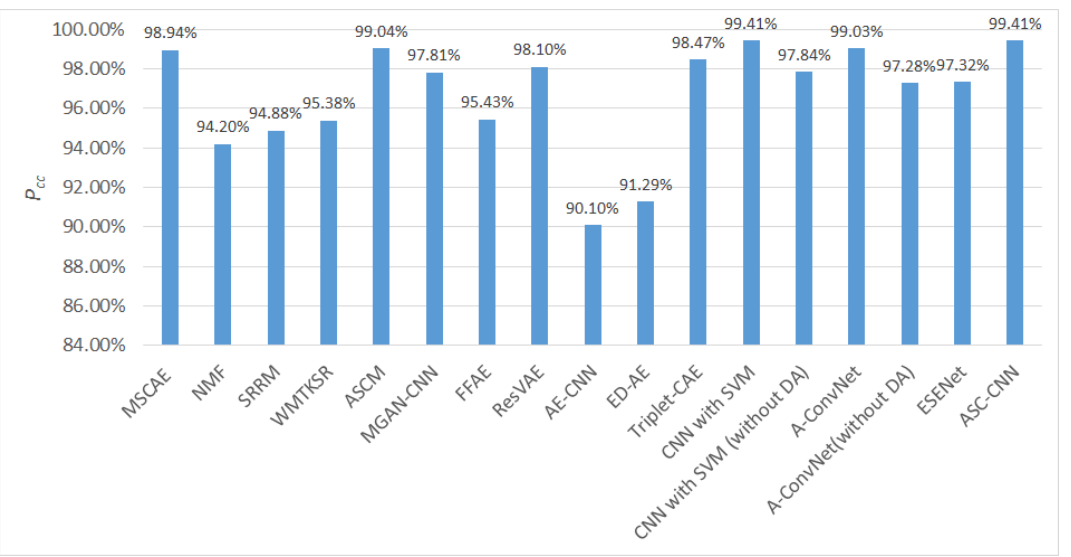
Figure 12. Performance comparison on the ten-target dataset with different handcrafted feature extraction methods and deep representation models.